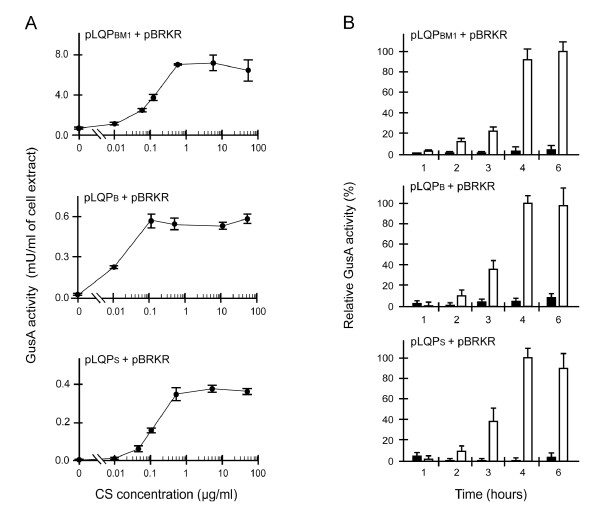
Functional characterization of the CS-CbnK-CbnR system-controlled promoters PS, PB, and PBM1 in Carnobacterium maltaromaticum. Dose-response curves showing GusA activity as a function of CS concentration (A) and time course showing the GusA activity of cultures treated with 20 μg/ml of CS (white columns) or 0.05% trifluoroacetic acid (black columns) (B). In the time course experiment, the cultures were harvested for GusA activity determination at the indicated times. GusA activity was determined as described in Methods. Means ± standard error of triplicate assays are shown.